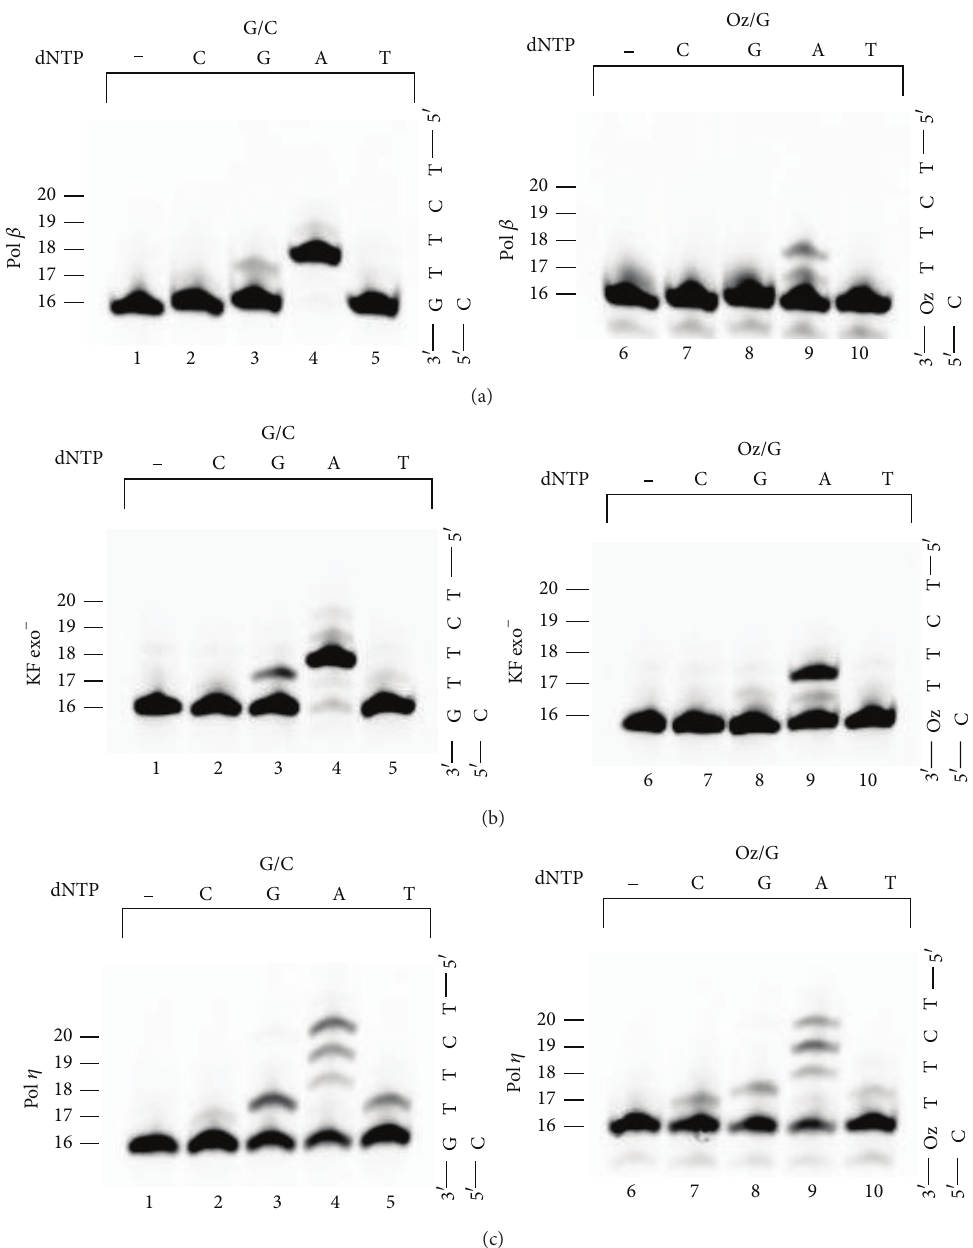
Figure 6: Nucleotide incorporation opposite the bases adjacent to G or Oz by Pol 𝛽 (a), KF exo − (b), or Pol 𝜂 (c). Left panels of (a), (b), and (c) show the control, which was extension of primers containing C opposite an undamaged G in the template. Right panels of (a), (b), and (c) show the extension of primers containing G opposite Oz in the template. The amount of Pol 𝛽 or Pol 𝜂 was 25mU or 11.5 ng; the amount of KF exo − was 25 𝜇 U for the left panel or 250 𝜇 U for the right